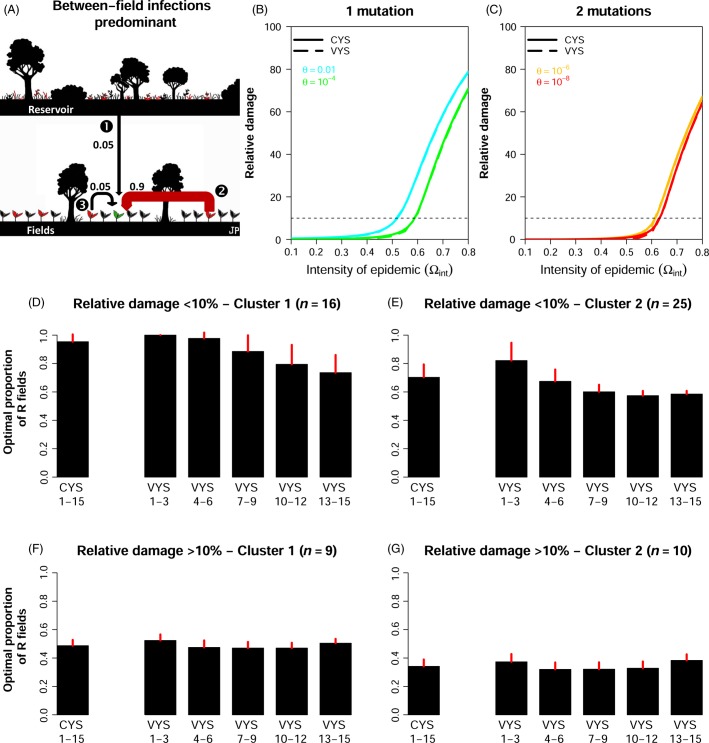
Comparison of damage reduction achieved with constant-mixture and variable-mixture yield strategies in a landscape in which epidemic dynamics are driven mostly by between-field infections. (A) In this landscape, before R deployment, 90% of infections are between-field infections (arrow ). (B, C) Effects of the choice of resistant cultivar (θ) and of epidemic intensity before the deployment of the resistant cultivar () on the relative damage obtained with constant-mixture yield strategies (CYS) and variable-mixture yield strategies (VYS). (D, E). Clustering into two groups of the time series of the optimal proportion of R fields in VYS when the relative damage obtained with CYS is <10% (41 of the 60 parameter combinations displayed in graphs B and C). (F, G) As for (D, E), but for relative damage obtained with CYS ≥10% (19 of 60 cases). Please refer to Fig. 1 for further details.